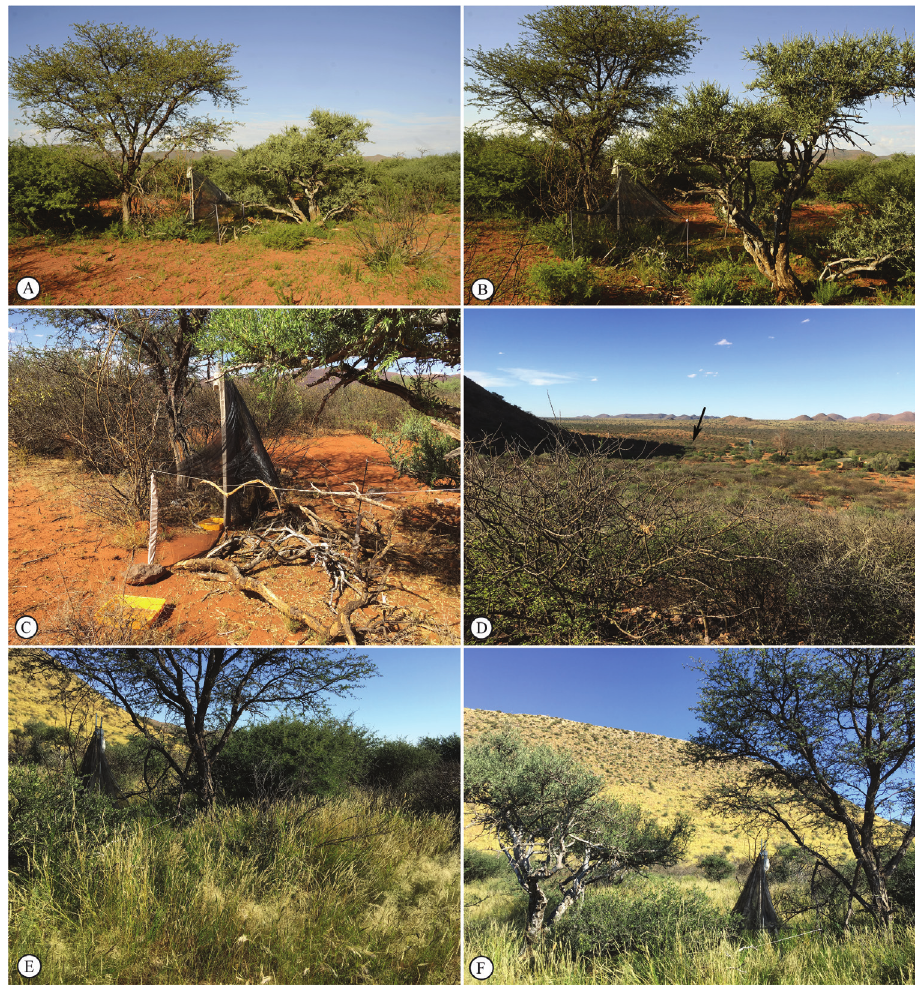
Figure 7. Spathioplites phreneticus South African sampling site locality TSW15-DED3 in Tswalu Kala- hari Game Reserve showing seasonal changes in habitat A habitat May 2016, after poor summer rains B habitat May 2016, after poor summer rains C habitat Nov 2016 at end of dry winter season showing dead wood stacked under Malaise trap to increase return on parasitoids of wood-boring hosts (Malaise trap damaged by game animals prior to fixing) D habitat overview Nov 2016 (locality arrowed) at end of dry winter season E habitat May 2017, after good summer rains F habitat May 2017, after good summer